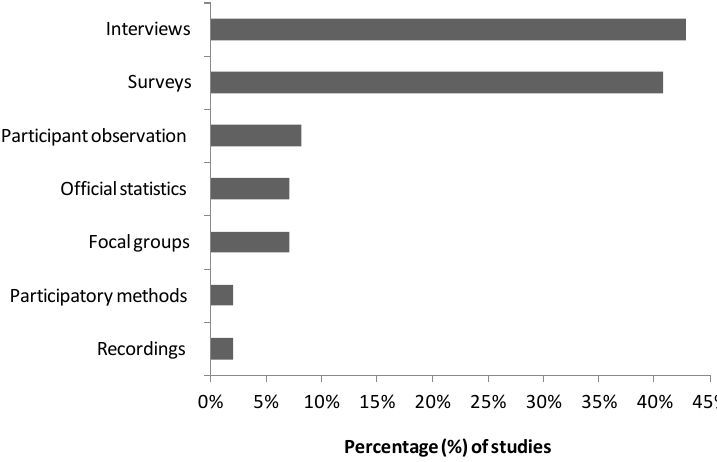
Figure 6. Methodological tools to assess intervention effectiveness.